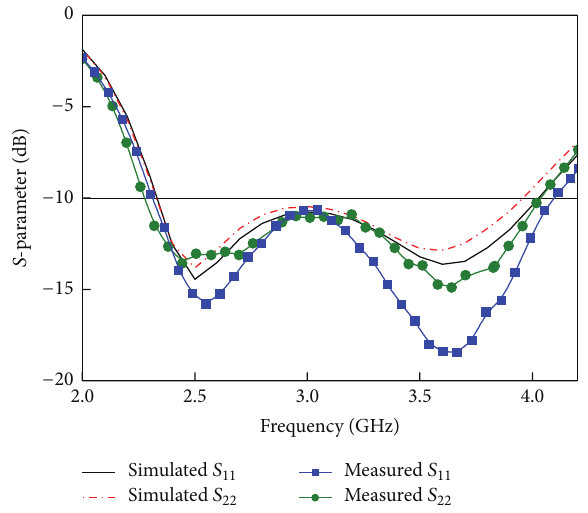
Figure 6: Measured and simulated S11/S22 of the proposed